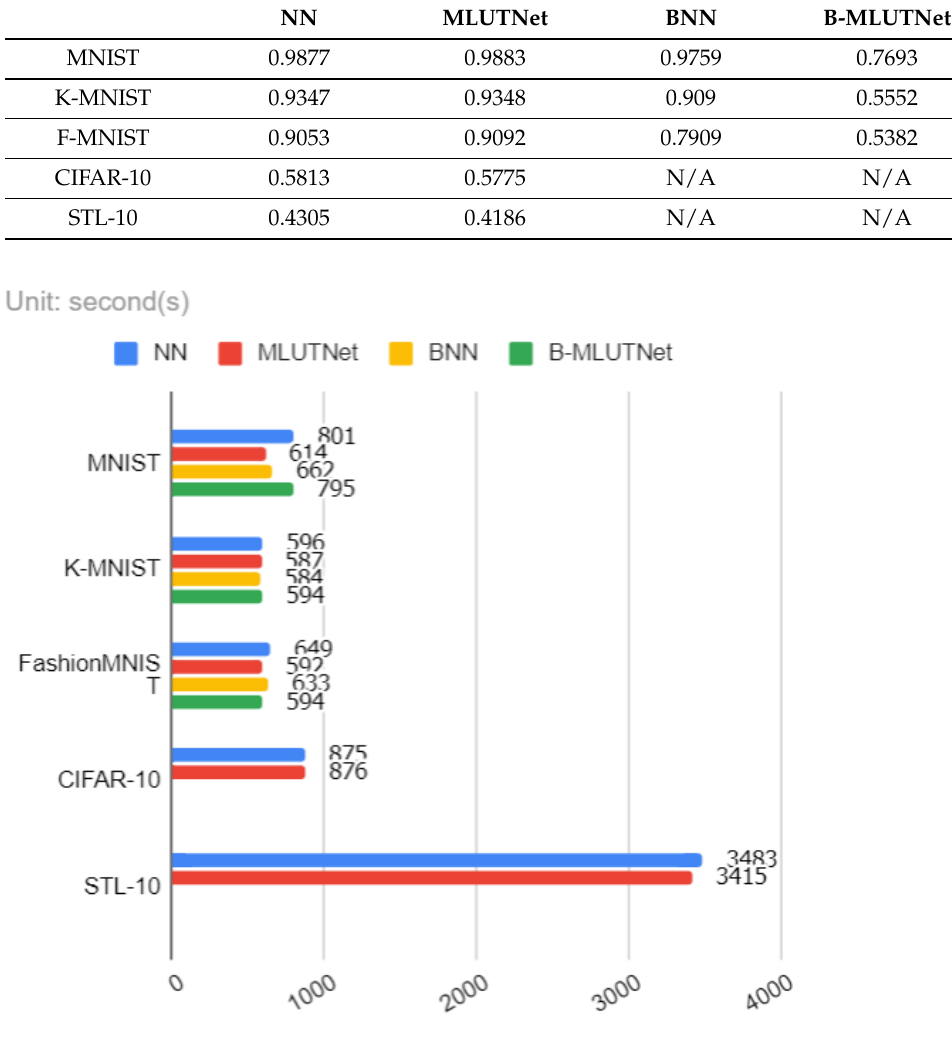
Figure 10. Models operation